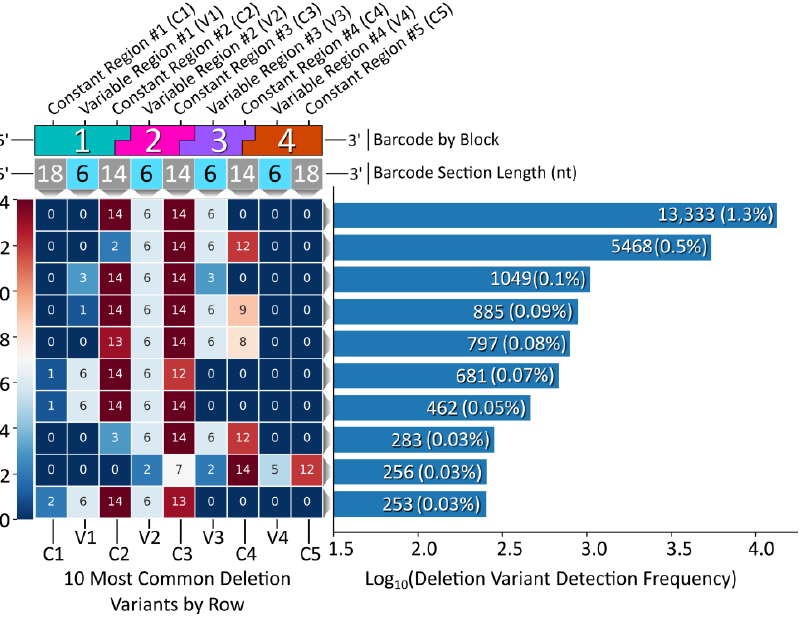
Figure 4. Gen_1 deletion variant analysis. Left, a heatmap displaying the top 10 deletion variants. Each block corresponds to a certain section within each barcode, top, with constant regions referring to overhang sequence domains between blocks and variable regions corresponding to the unique sequences internal to each block in the modular design. The number within each block represents the number of deleted nucleotides for that section. Right, a histogram displaying the detection frequency for the top 10 variants out of the 1 M read subset.